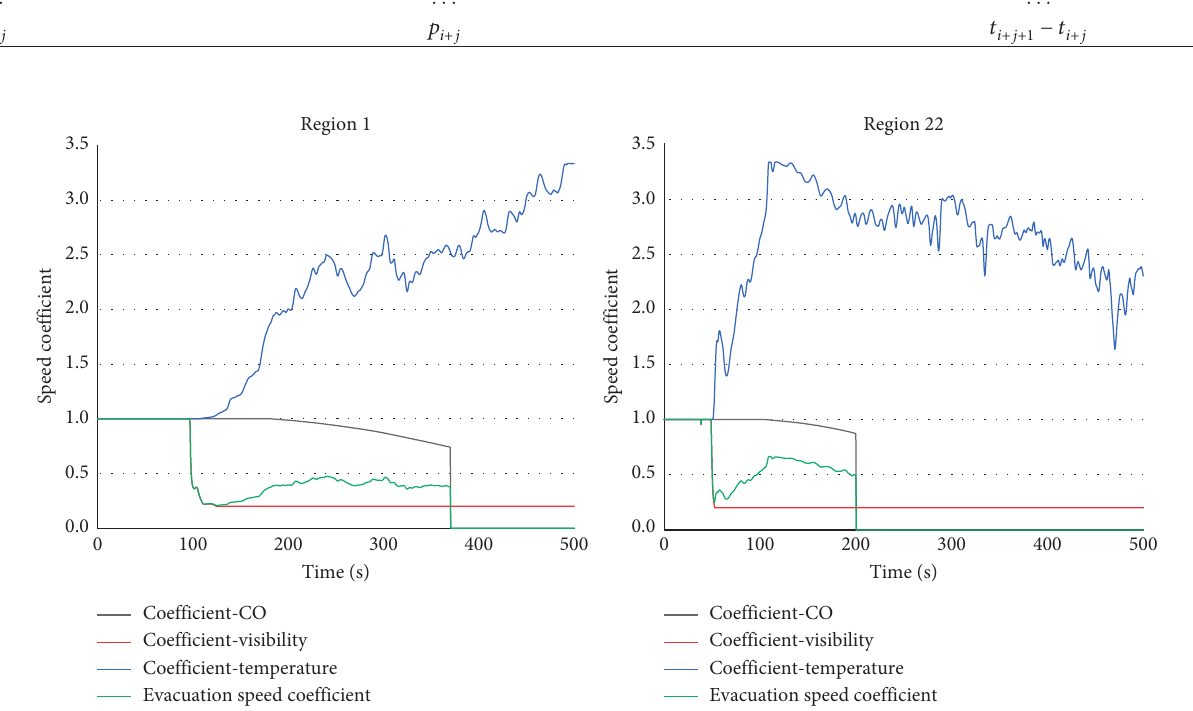
Figure 9: Comparison of speed coefficient curves between region 1 and region